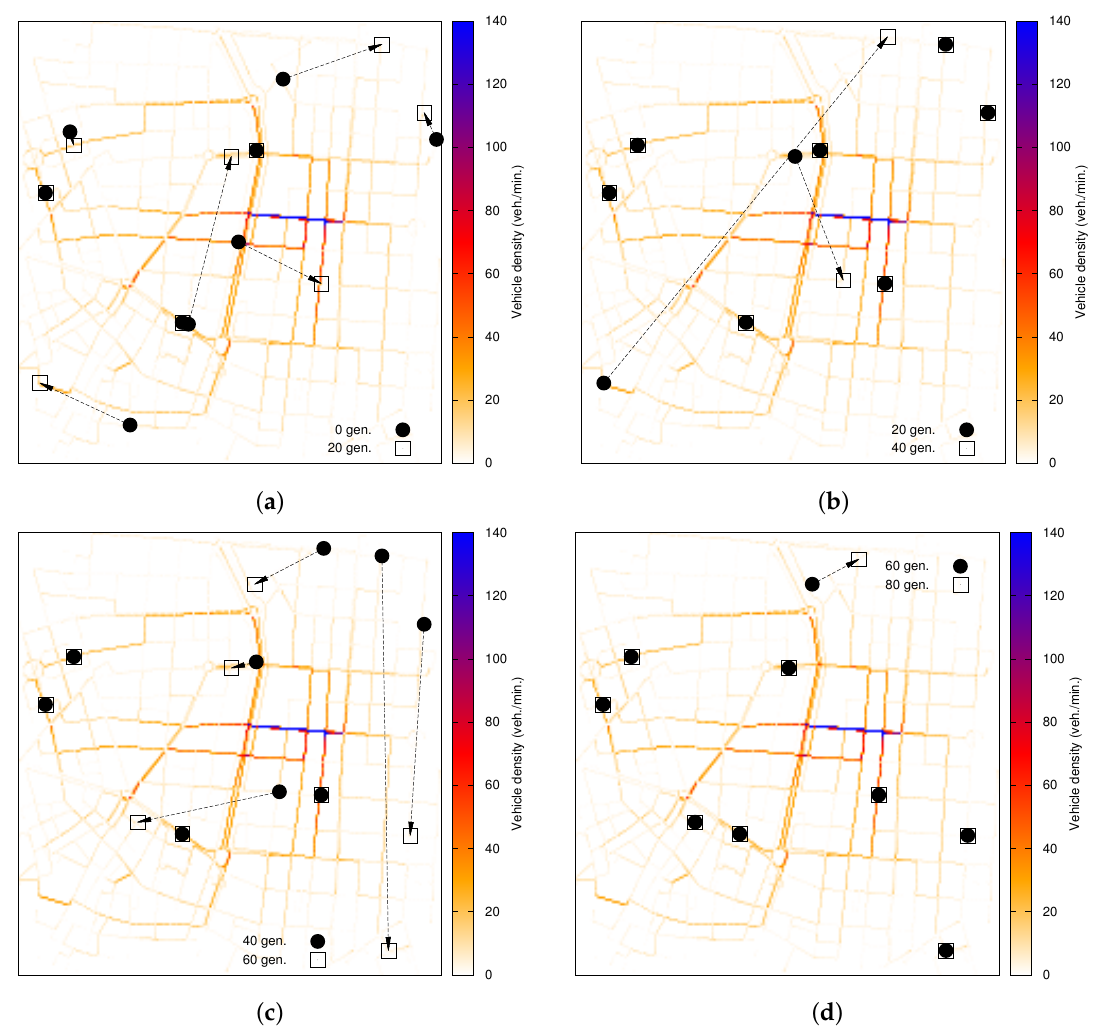
Figure 7. Evolution of the deployment of nine RSUs in the Madrid scenario using GARSUD. ( a ) After 20 generations; ( b ) after 40 generations; ( c ) after 60 generations; ( d ) after 80